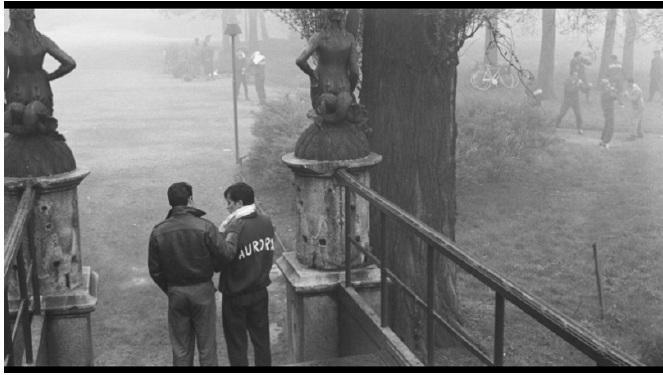
Figure 4 Screenshot from Rocco and His Brothers. (Goffredo